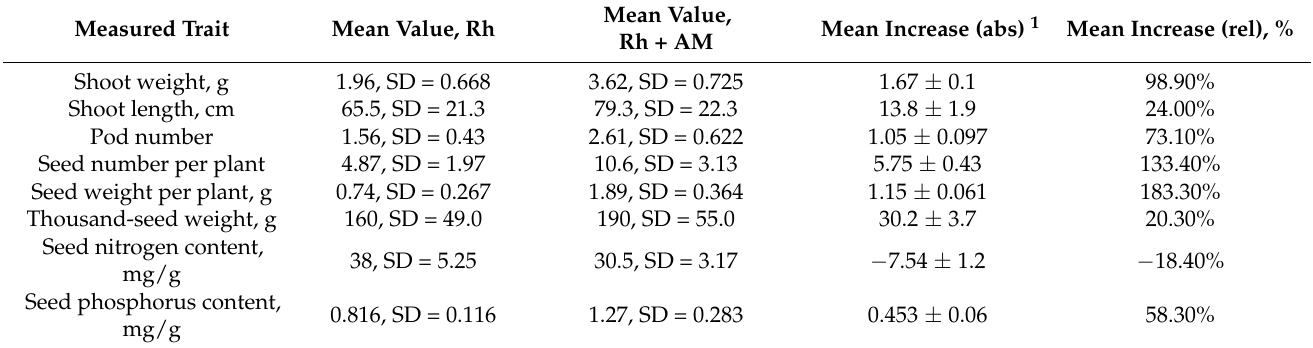
Table 2. The traits analyzed for pea plants grown in Rh and Rh + AM conditions.